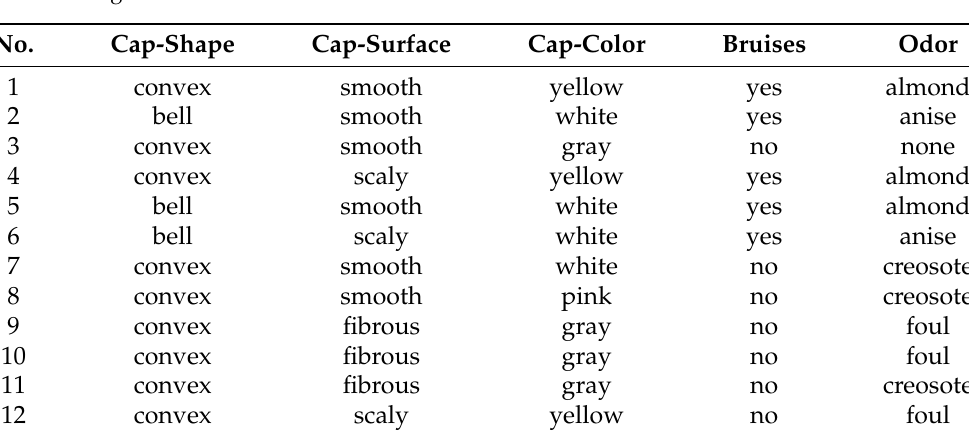
Table 3. Fragments of the Mushroom dataset.